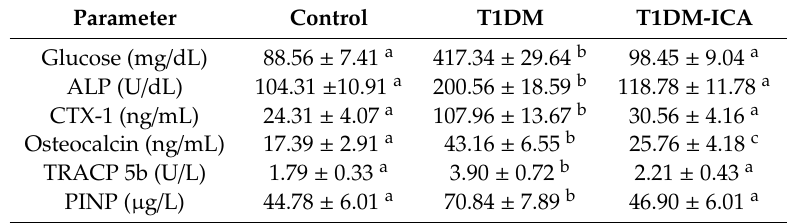
Table 1. Blood glucose, and serum bone turnover markers in each experimental group.